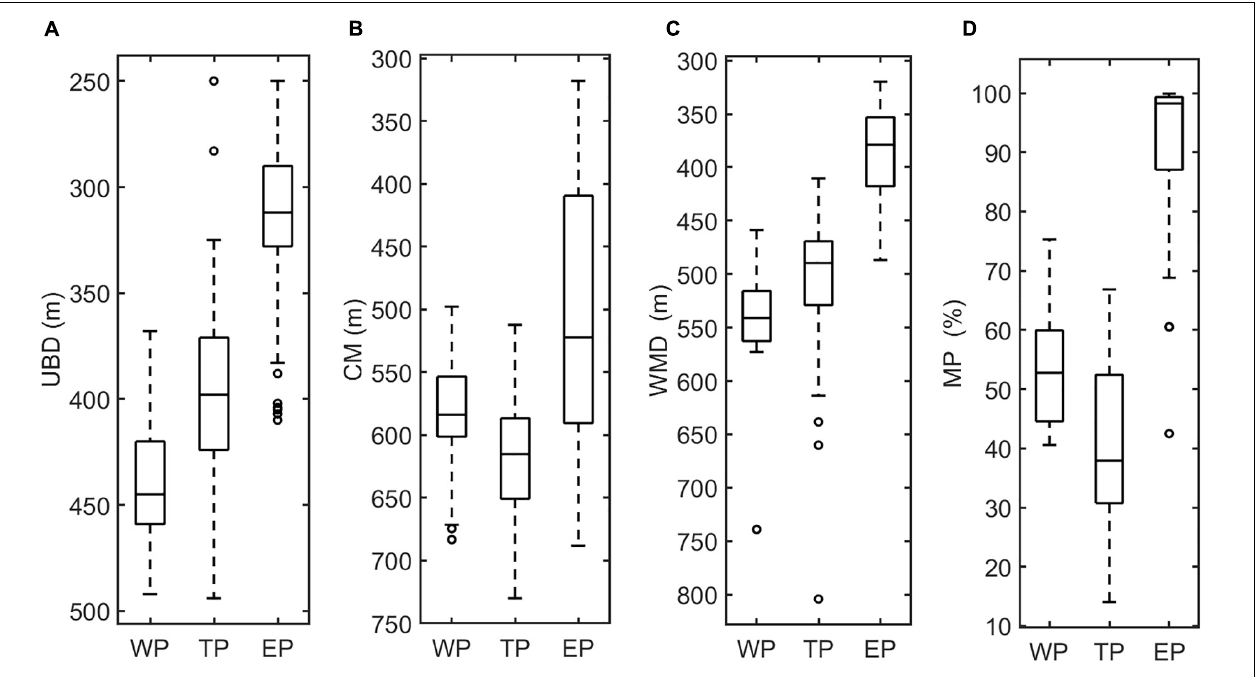
FIGURE 4 | Box plots of the features of DSLs and DVMs, showing the differences among three parts. (A) , UBD (m); (B) , CM (m); (C) WMD (m); and (D) , MP (%).